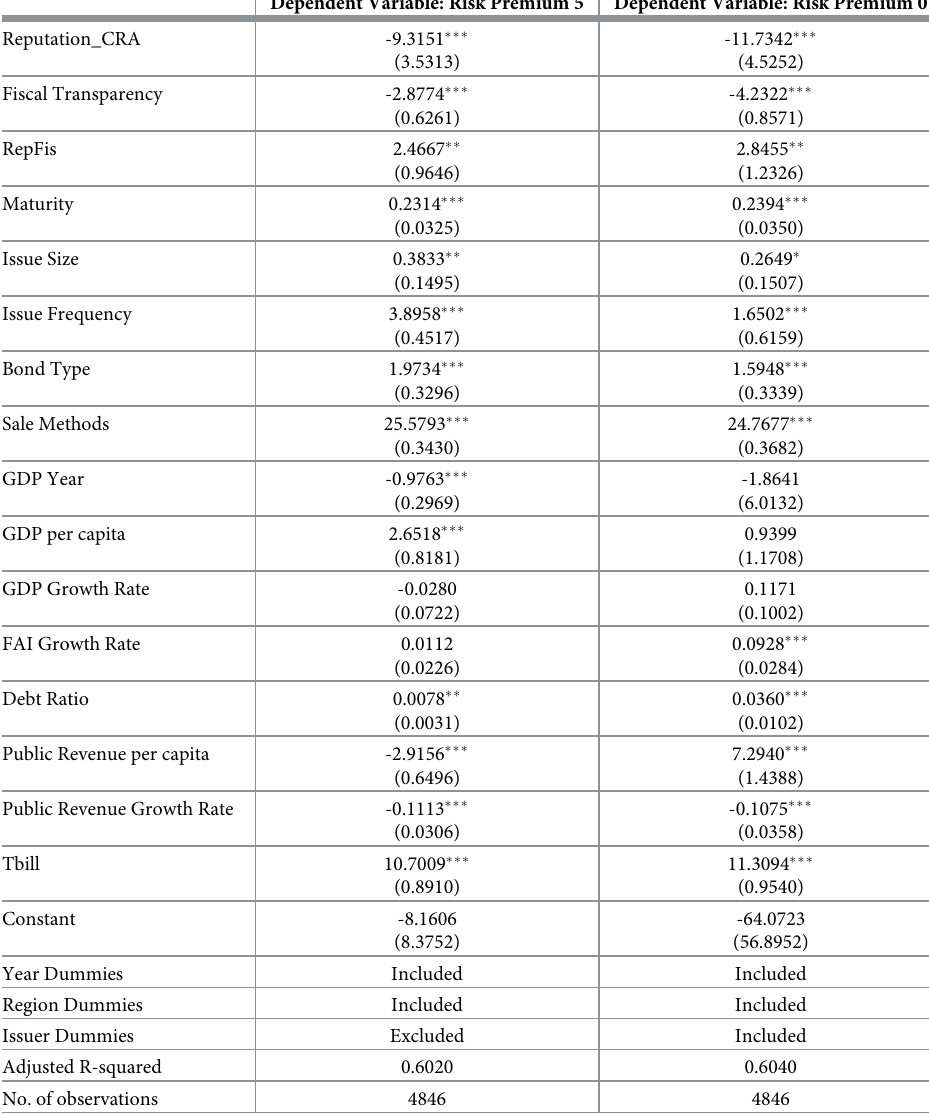
Table 15. Regression results based on the subperiod sample. This table reports the estimates of the baseline regres- sion Eq (1) from 2015 to 2019, with robust standard